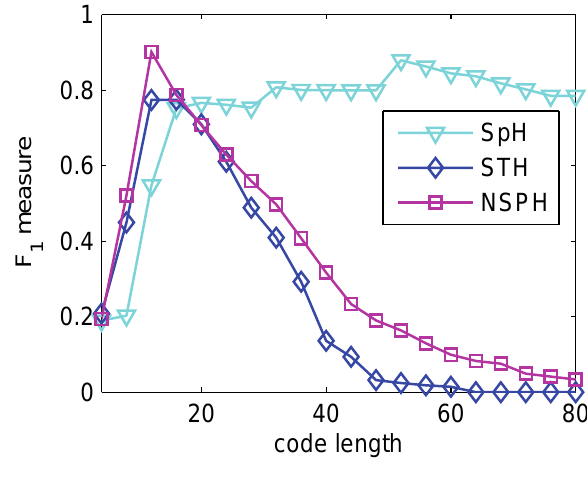
Fig. 4. F1-measure of the comparative algorithm under var- ious code length.